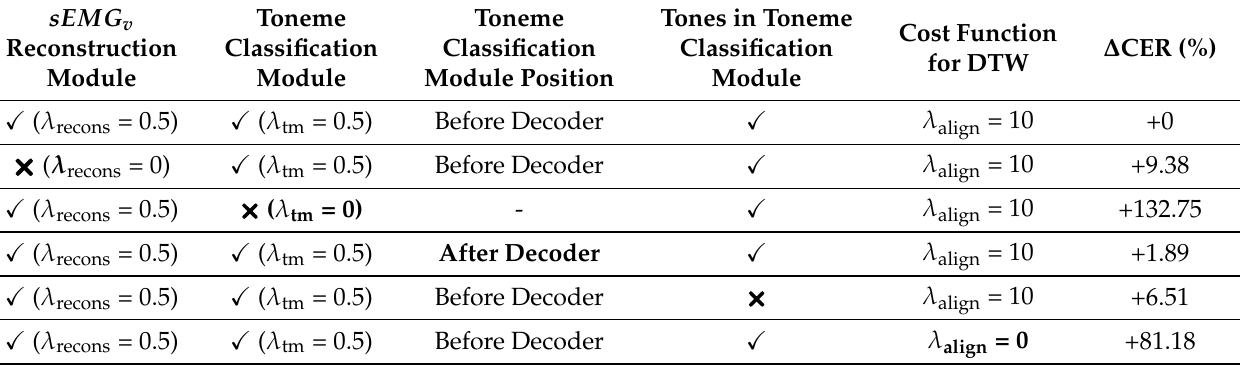
Table 6. Ablation Results from the Model Module